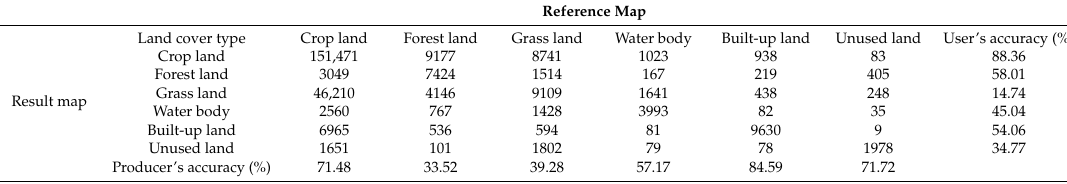
Table 8. Confusion matrix between the NASA product and the reference